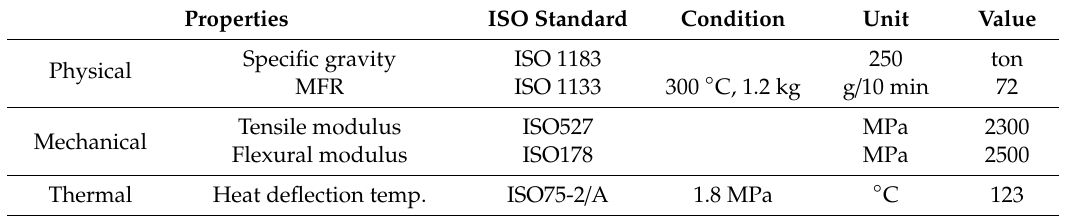
Table 1. Material properties of Iupilon HL4000 (Mitsubishi Co. Ltd.).